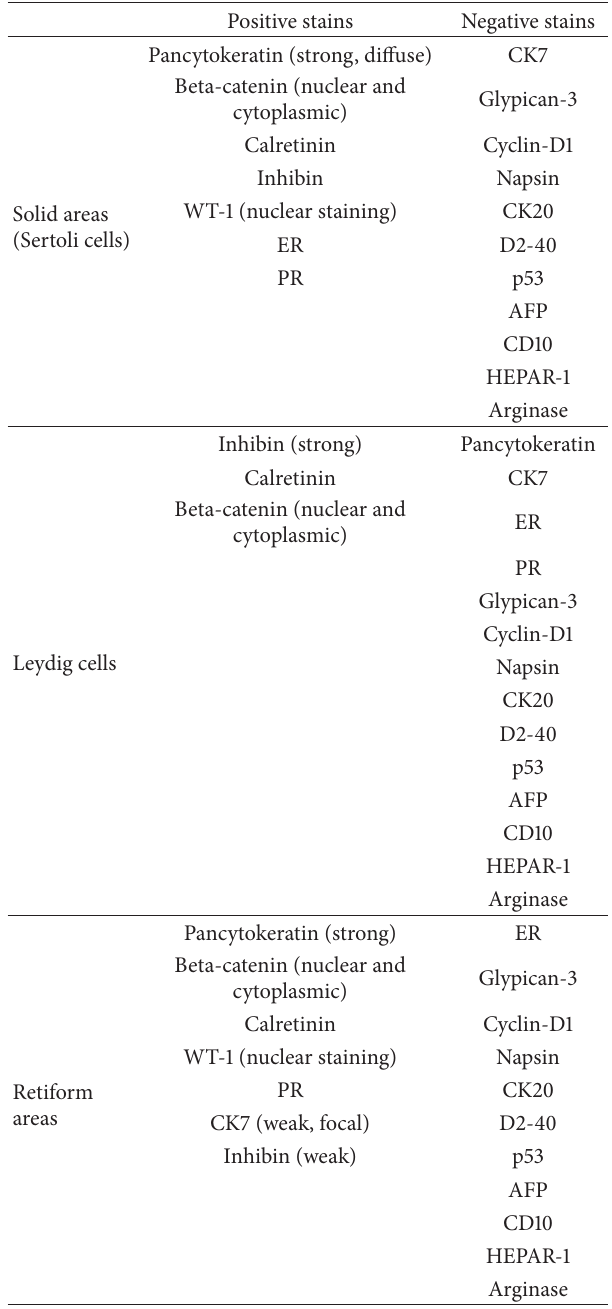
Table 1: Summary of immunohistochemical profile of the tumor by